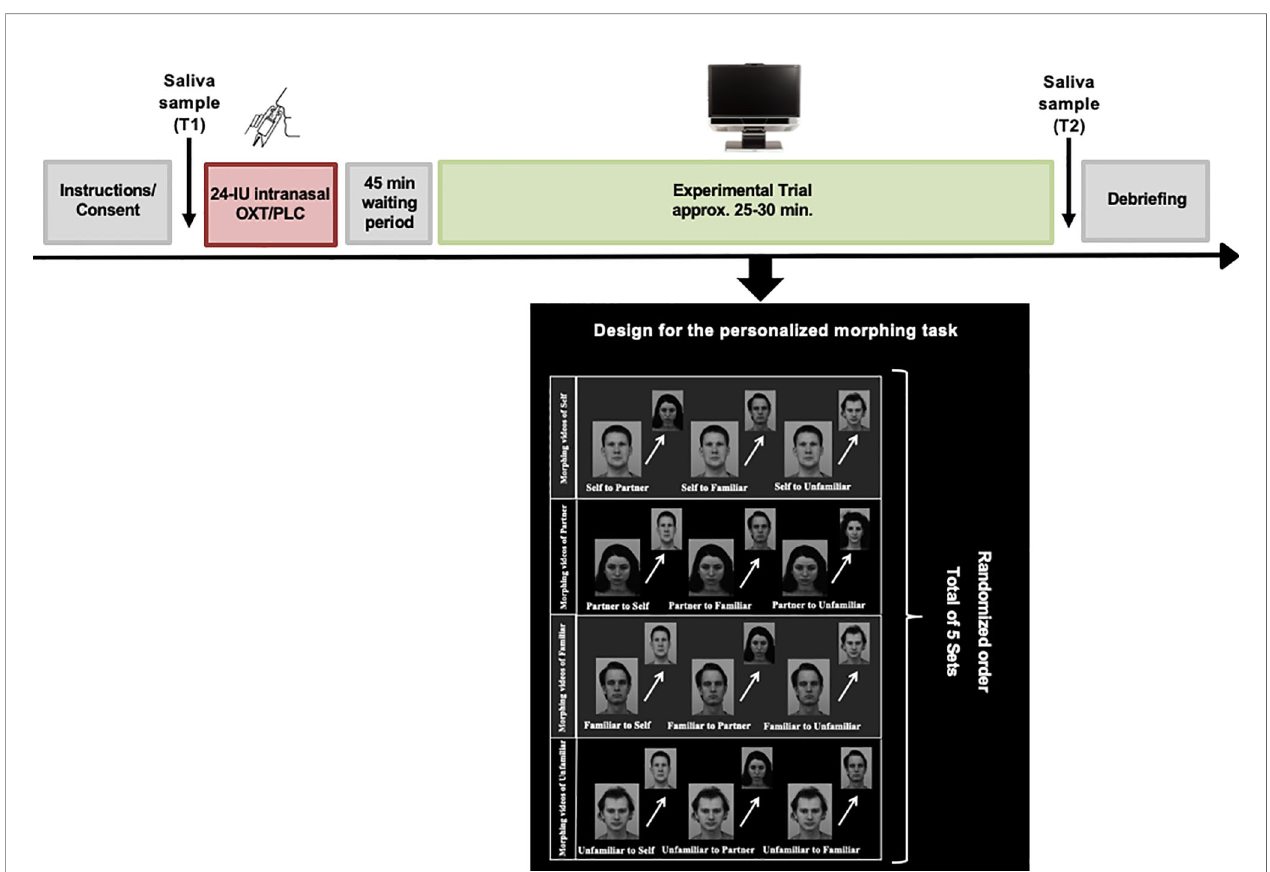
FIGURE 2 | Overview of the experimental design. After intranasal administration of oxytocin or placebo spray and a waiting period of 45 minutes, the participants were seated in front of the eye-tracker. Following calibration, they were exposed to the experimental task consisting of twelve personalized morphing videos involving four categories of faces ( “ self ” , “ partner ” , “ familiar ” , “ unfamiliar ” ). A total of fi ve sets each consisting of twelve individual videos were shown to the participants in randomized order. After each set, a fi xation cross was presented to ensure that the eyes of the participants were in a neutral position on the screen. Saliva samples were collected prior to the self-administration of the nasal spray (T1) and after completion of the experimental trial (T2). In this fi gure, facial images from the Karolinska Directed Emotional Faces (KDEF) database. The image ID's AF15NES, BM11NES, BM13NES, BM21NES are used for this illustration purpose